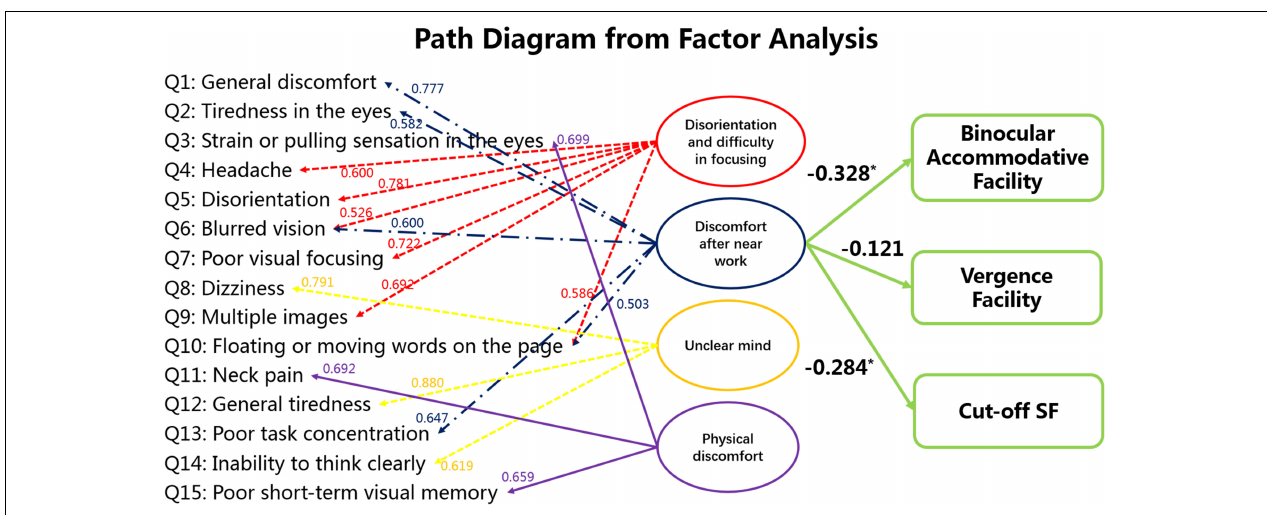
FIGURE 5 | Statistical analysis among subjective symptoms and visual functions (binocular accommodative facility, vergence facility and Cut-off SF). The values between the score of each item in the questionnaire and the latent factors indicate the standardized factor loading scores from the factor analysis. Factor #2 is the focus here because it seems to be strictly concerned with visual fatigue. The values between the latent factor “discomfort after near work” and the visual measures were obtained from bivariate correlation. * p <